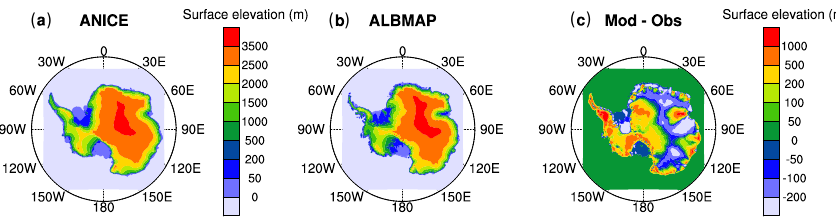
Figure 5. Surface elevation of the PD ice sheet (a) as modelled, (b) as observed (ALBMAP), and (c) the difference between (a) and (b) .